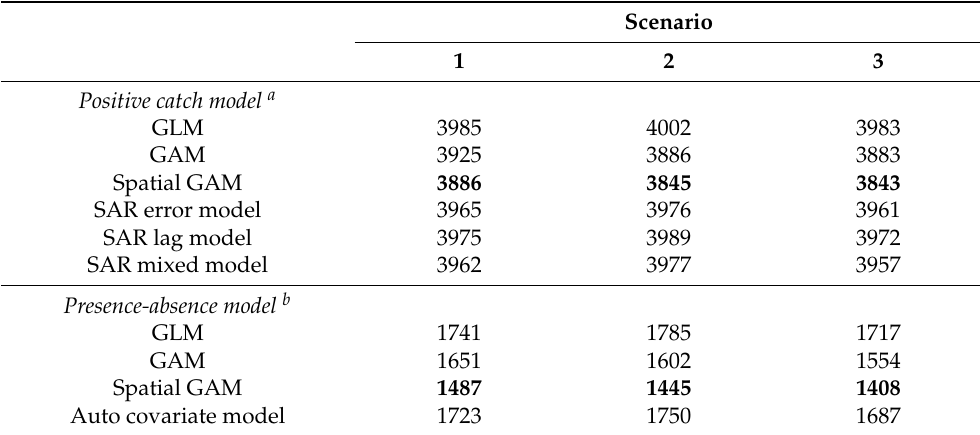
Figure 3. Pairwise scatter plots and Spearman correlation coefficients between explanatory variables collected by the NEAMAP survey. Abbreviations are as follows: DO = dissolved oxygen, PS = percentage of oxygen saturation, DE = depth, WT = water temperature, SA = salinity, LA = latitude, LO = longitude. Table 1. AIC comparison of the three variable selection scenarios for each six model types fitted to NEAMAP weakfish survey data. Scenario 1: month but no water temperature; Scenario 2: water temperature but no month; Scenario 3: both water temperature and month.